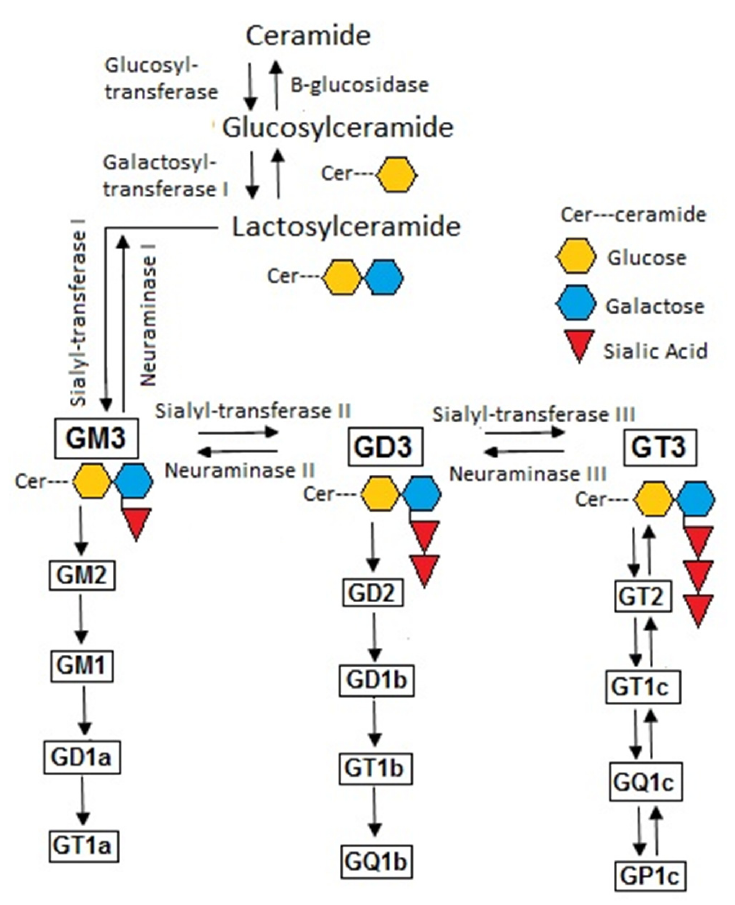
Figure 1. General Scheme for ganglioside biosynthesis. G indicates ganglioside; M indicates monosialo; D indicates disialo; T indicates trisialo; numbers indicate carbohydrate synthesis. The reactions of sialyl-transferases transfer sialic acid units. The reactions of neuramidases remove sialic acid units.